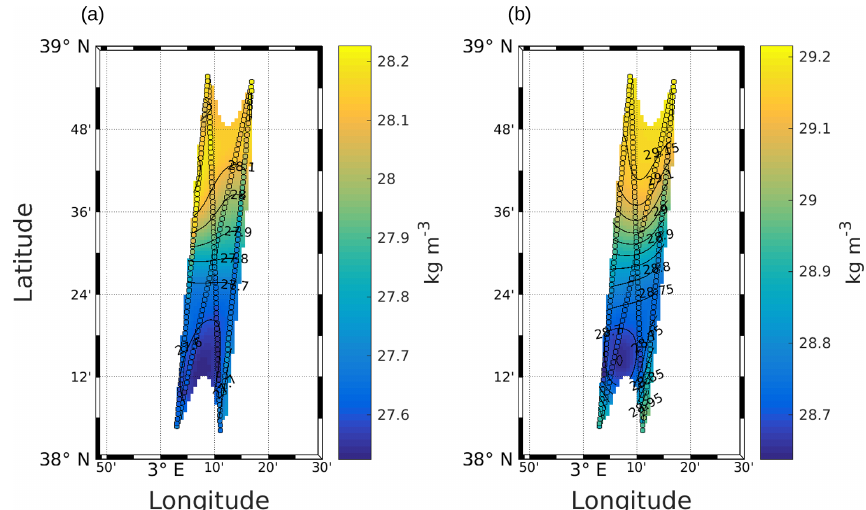
Figure A1. Objective mapping of potential density anomaly σ at 25m (a) and 85m (b) . The circles represent σ as measured by the SeaSoar, along the transects used for the interpolation. Black lines represent σ contours. The data were selected where the error on the objective mapping of σ is ≤ 0 .